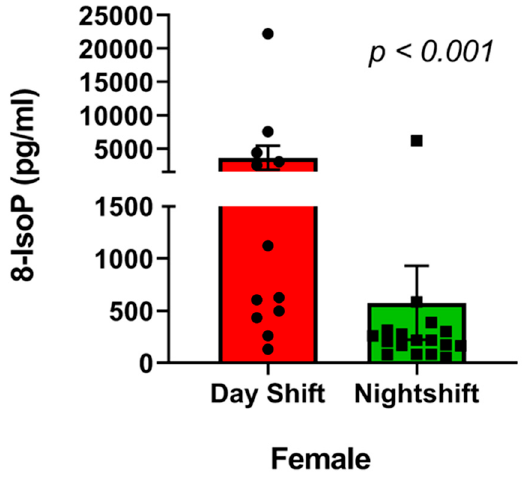
Figure 7. Graphical representation comparing 8-isoprostane levels in day shift and night shift female nurses. 8-isoprostane (8-IsoP) levels were measured in the urine samples and compared (female day shift nurses vs. female night shift nurses; p < 0.001) using Mann–Whitney non parametric test. A significant difference was observed in 8-IsoP levels between female day shift and night shift nurses ( p < 0.001).